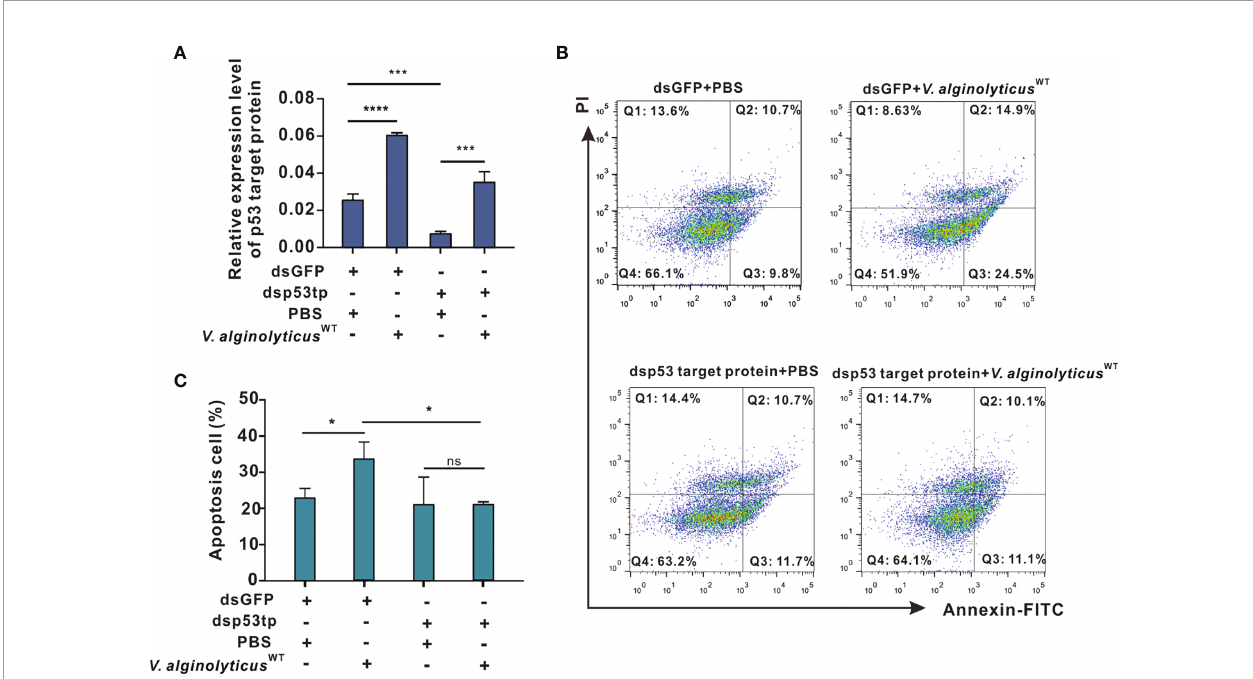
FIGURE 5 | p53 target protein mediates apoptosis in oyster hemocytes. (A) Relative expression levels of p53 target protein after RNAi in oyster hemocytes is as shown. mRNA levels were quanti fi ed by real-time PCR with GAPDH as a reference gene. Data were analyzed by one-way ANOVA and presented as mean ± SEM (n = 5); *** p < 0.001; ****p < 0.0001. Control group: dsGFP+PBS. p53tp, p53 target protein. (B) Representative dot-plot results in FACS for hemocyte apoptosis after double staining with annexin V-FITC and PI. Q1: necrotic/non-viable cells; Q2: late apoptosis/necrosis; Q3: early apoptosis; Q4: living cells. (C)